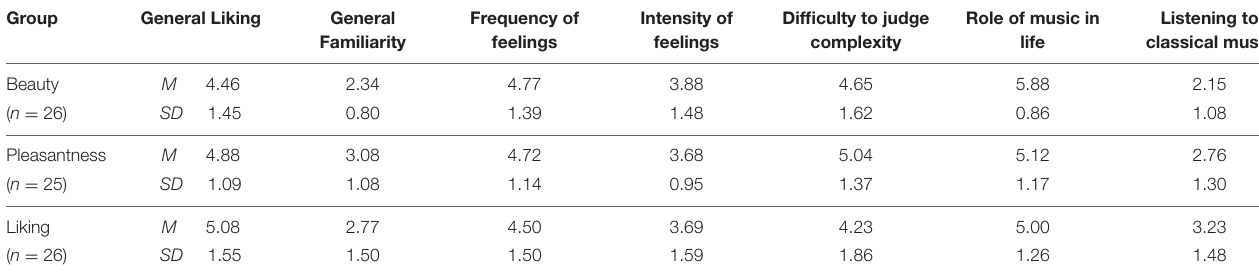
TABLE 10 | Post-experiment